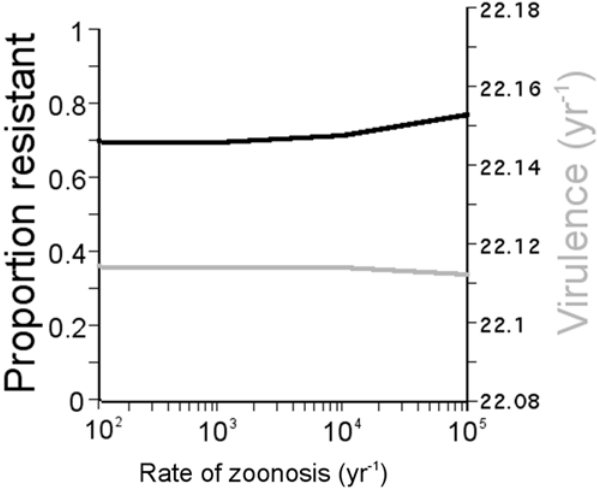
Figure 4. Effect of repeated influenza introductions from a wildfowl reservoir. The effect of repeated emergence of H5N1 on the selection for greater host resistance is negligible until annual rates of emergence reach 10 5 introductions. The impact of repeated emergence of H5N1 on the rate of influenza evolution towards higher virulence is also negligible for 10 5 introductions annually. Note that the scale for virulence on the y-axis comprises a very small range.